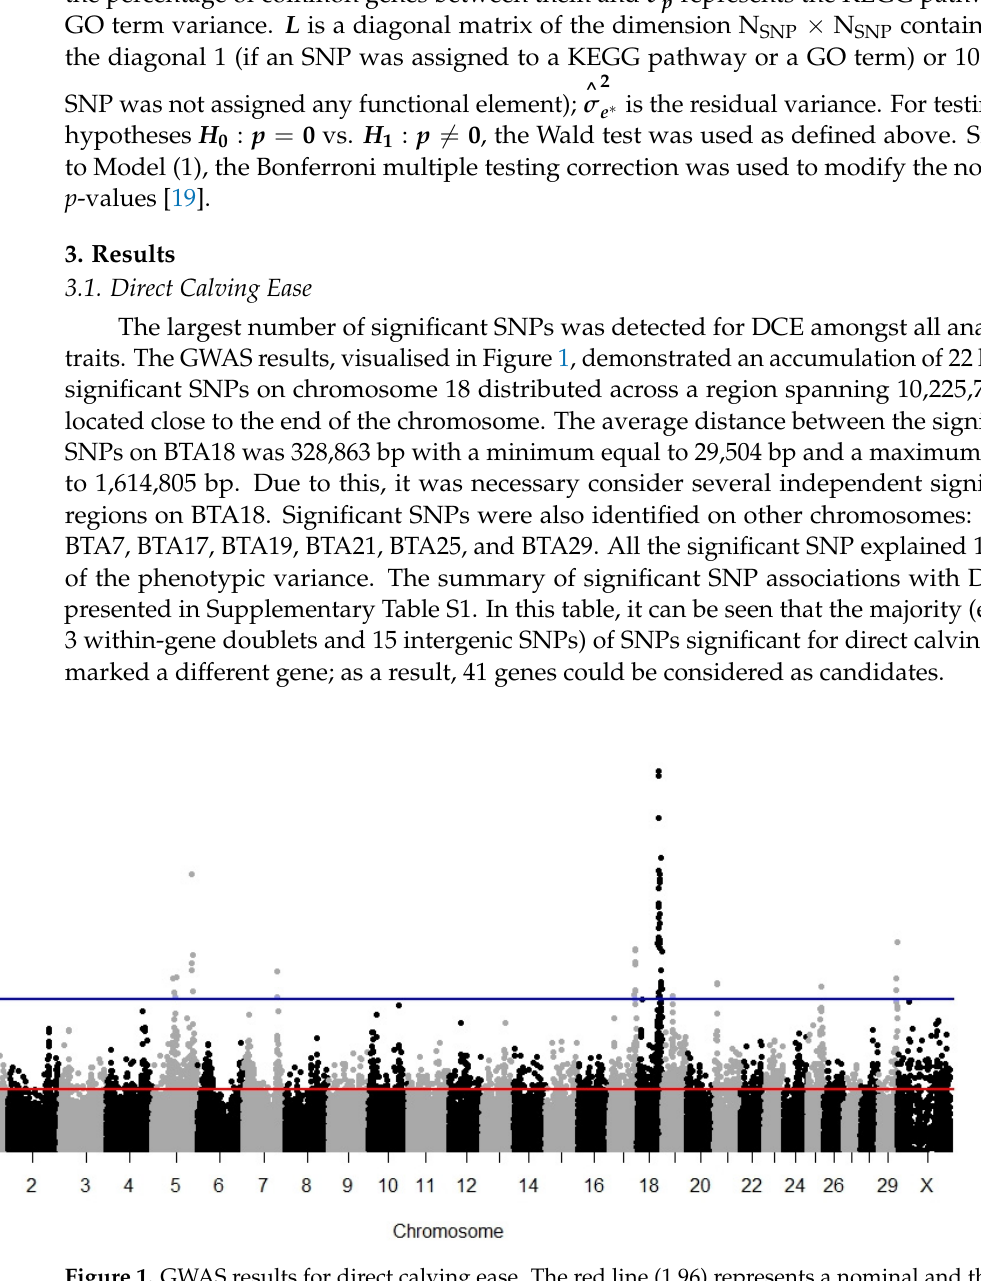
of a direct calving ease phenotype was